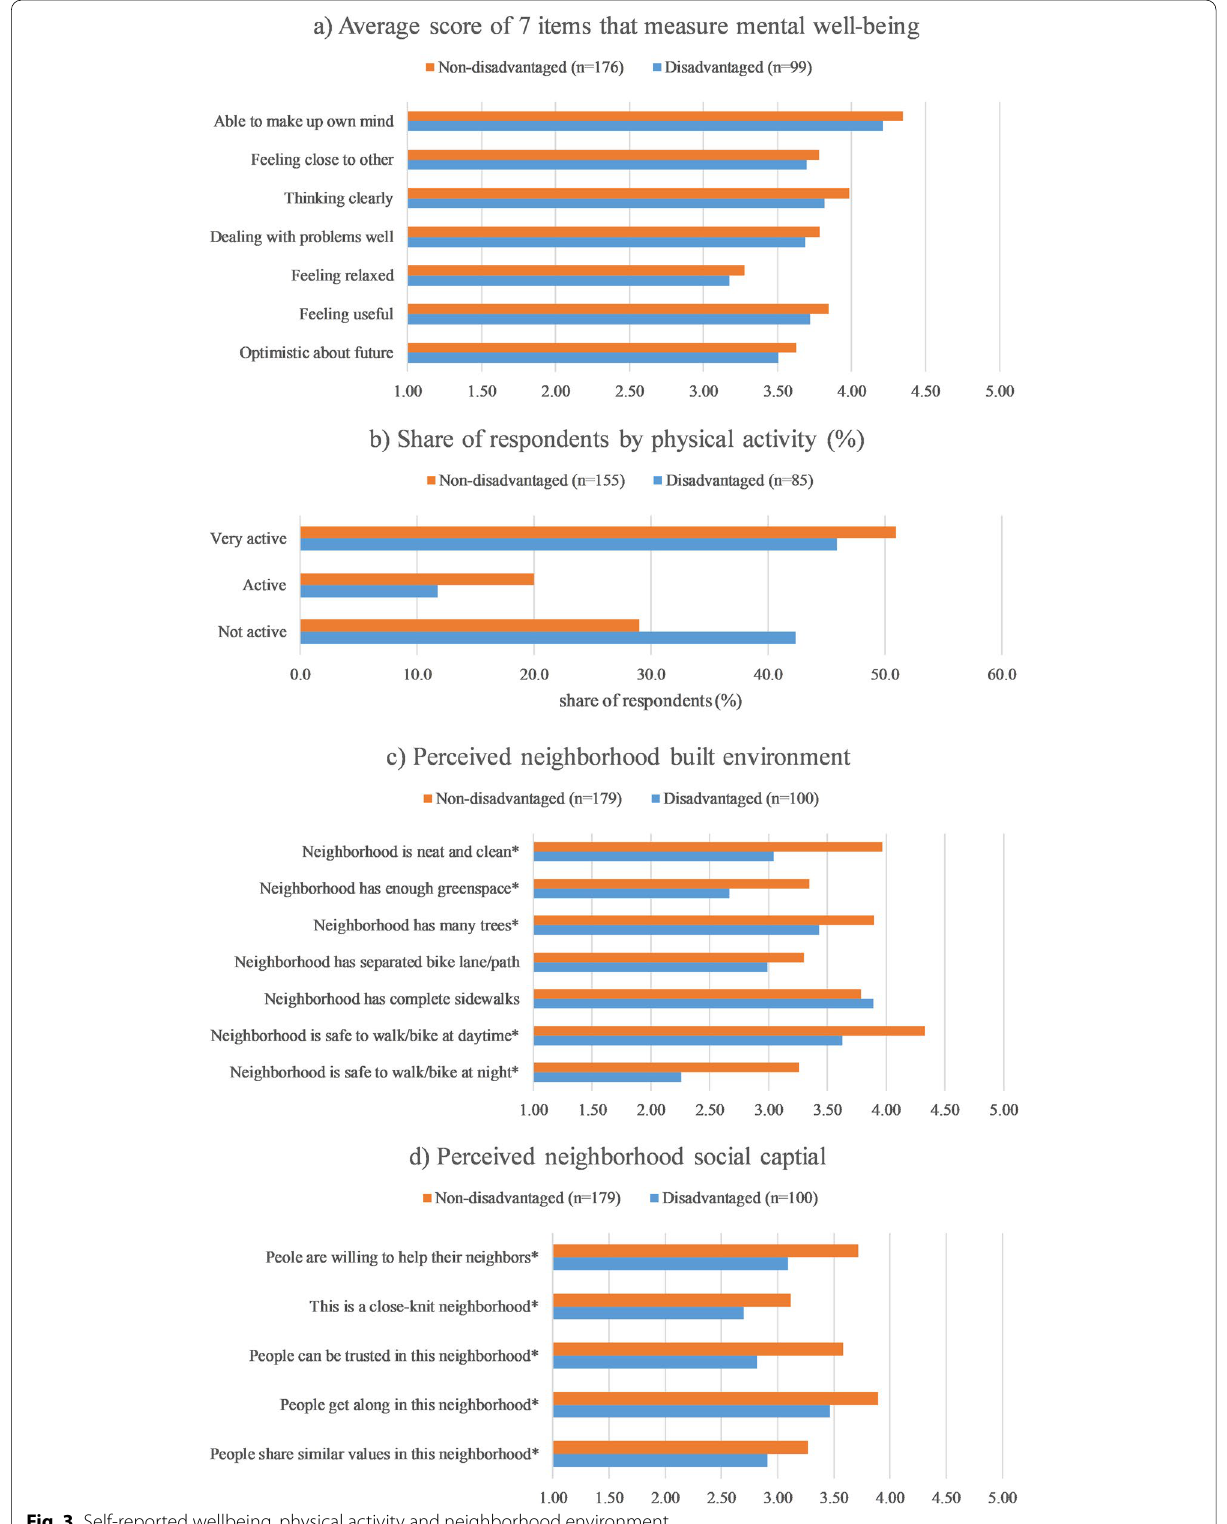
Fig. 3 Self‑reported wellbeing, physical activity and neighborhood